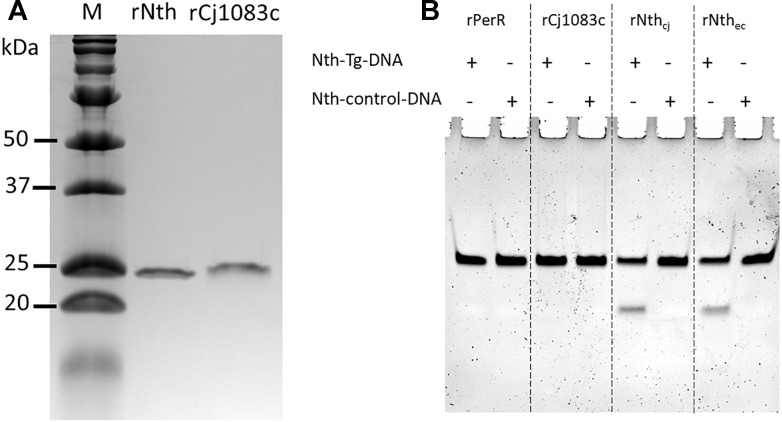
Production of the C. jejuni rNth and rCj1083c proteins in E. coli and evaluation of their Endonuclease III activities in vitro. (A) SDS-PAGE analysis of C. jejuni rNth and rCj1083c expressed in E. coli. Lane M contains molecular mass markers (Bio-Rad), while lane rNth or rCj1083c shows rNth or rCj1083c of C. jejuni NCTC 11168 purified by Ni-nitrilotriacetic acid affinity chromatography, respectively. (B) Urea PAGE analysis of endonuclease III activities of C. jejuni rPerR, rCj1083c, rNth (rNthcj) and E. coli Nth (rNthec), proteins. The ‘+’ and “–” signs indicate the presence and absence of the assayed DNA, respectively.